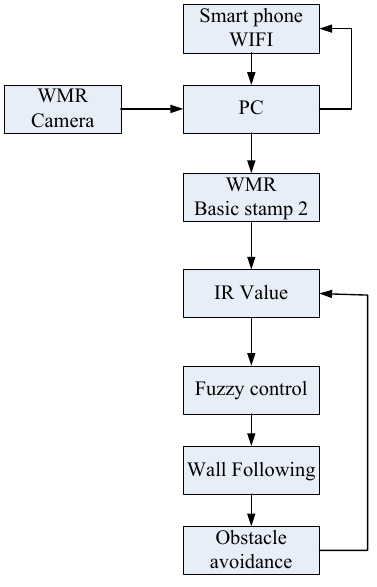
Figure 16. Remote control scheme.